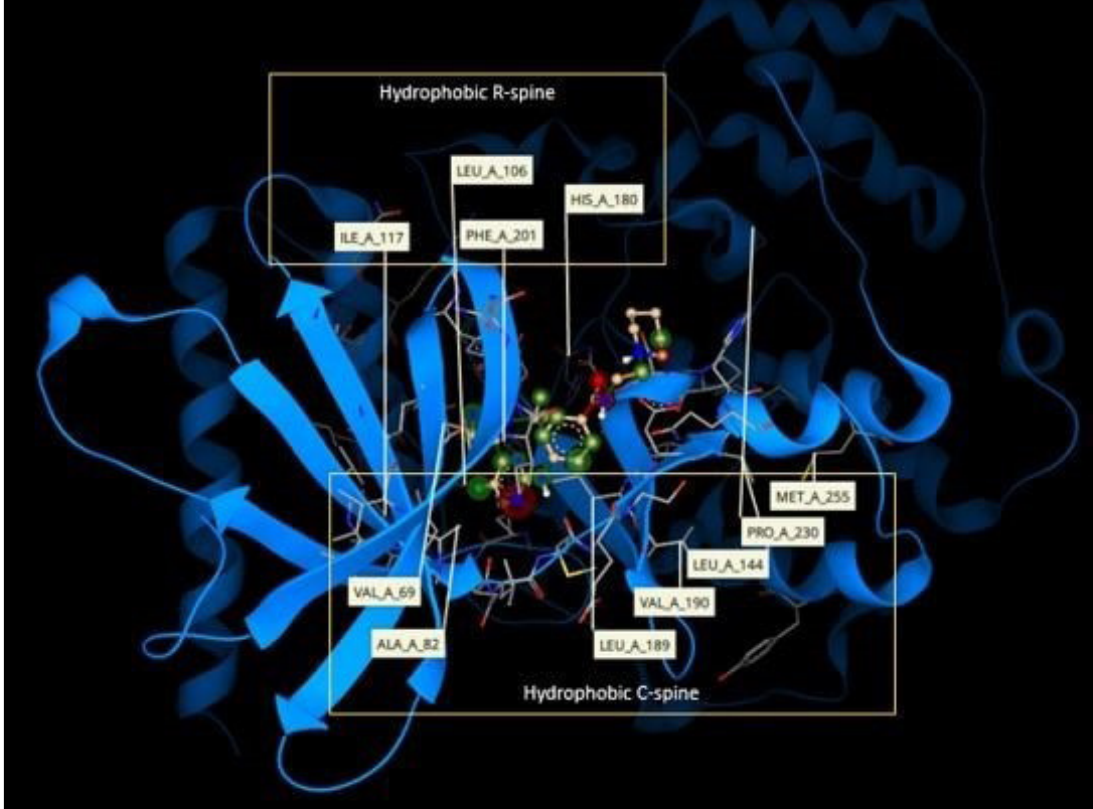
Figure-V: ERK5 hydrophobic spine in the binding